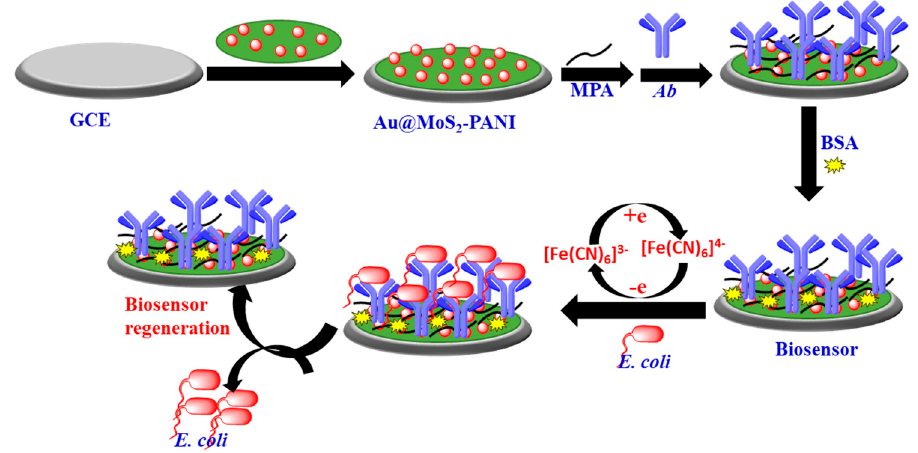
Figure 4. Schematic representation of the proposed electrochemical biosensor for E. coli.